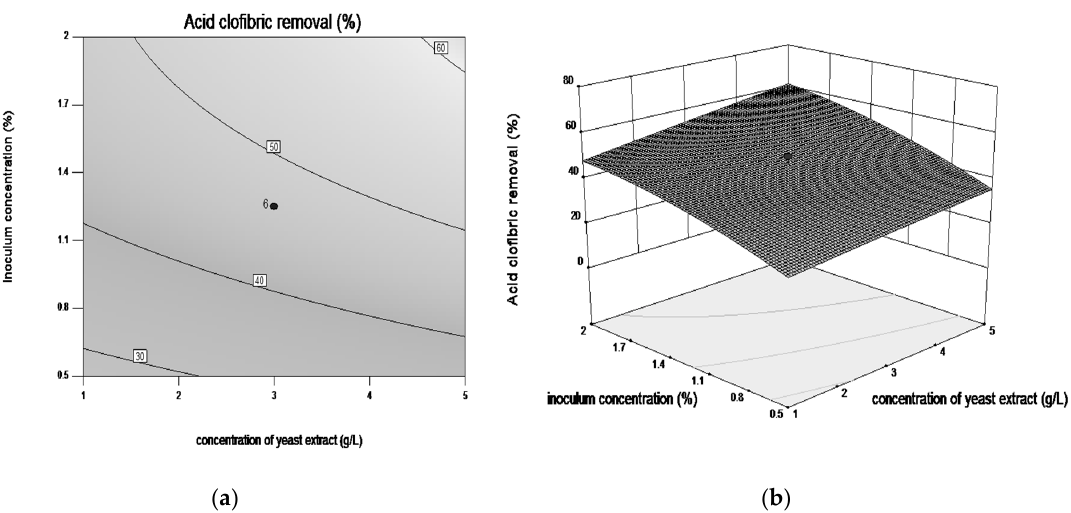
Figure 3. Contour plot ( a ) and three-dimensional surface plot ( b ) showing the effect between inoculum concentration and concentration of yeast extract on CLF biodegradation by Trametes pubescens.